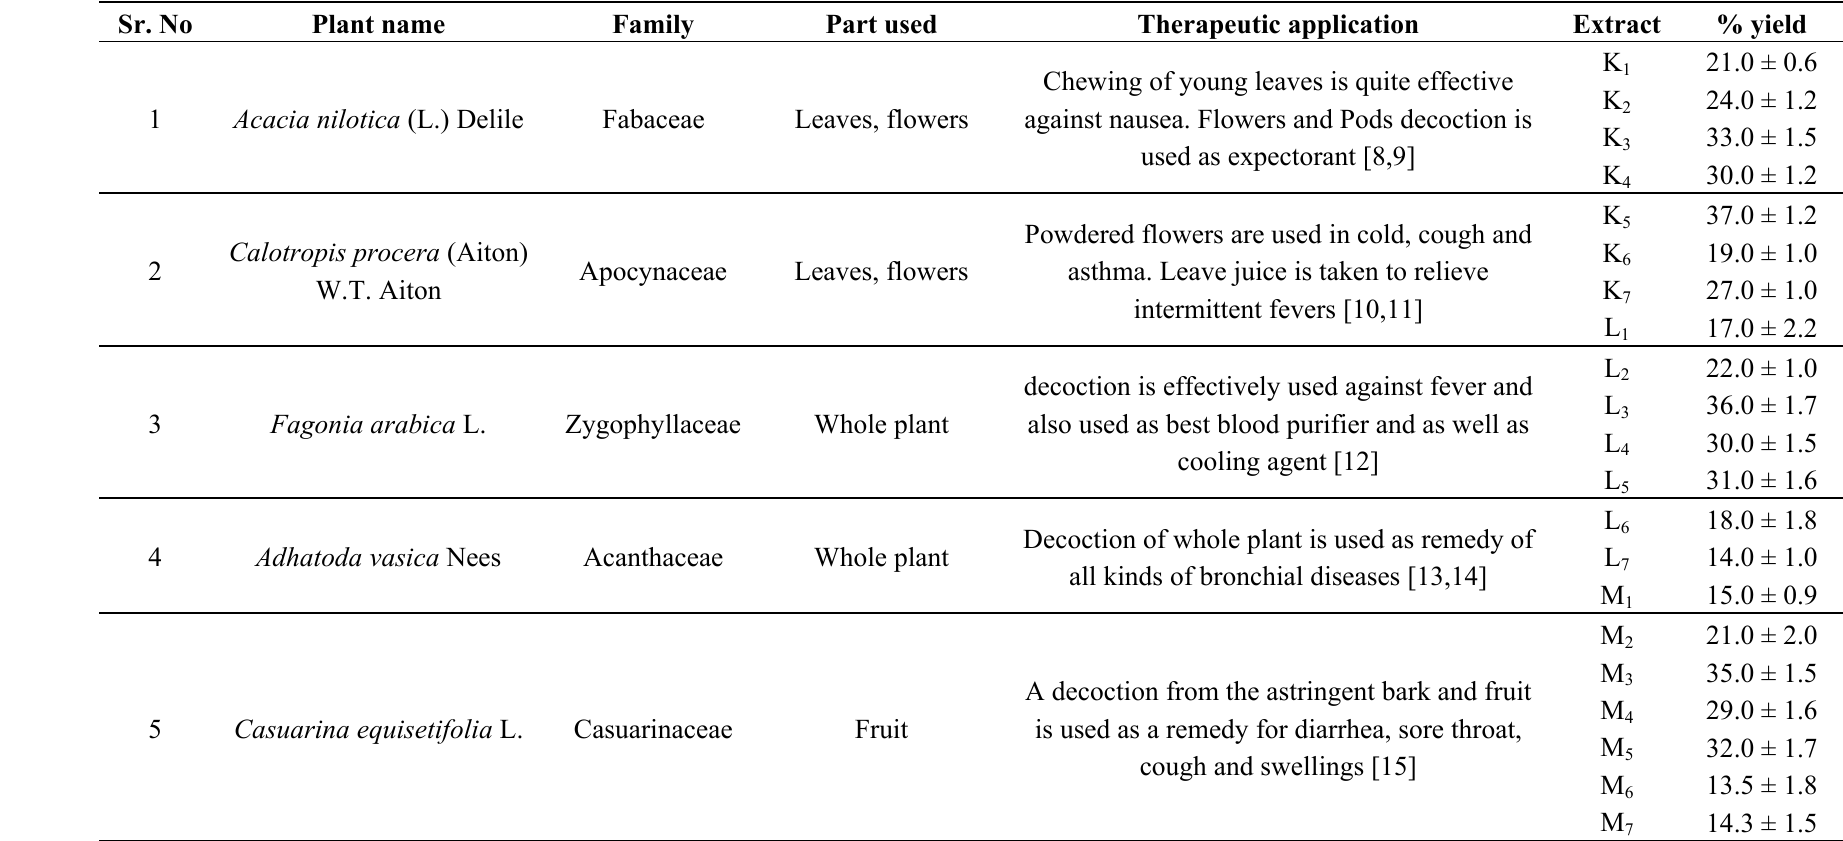
Table 1. List and extraction yields of indigenous medicinal plants, Soon Valley, Punjab,